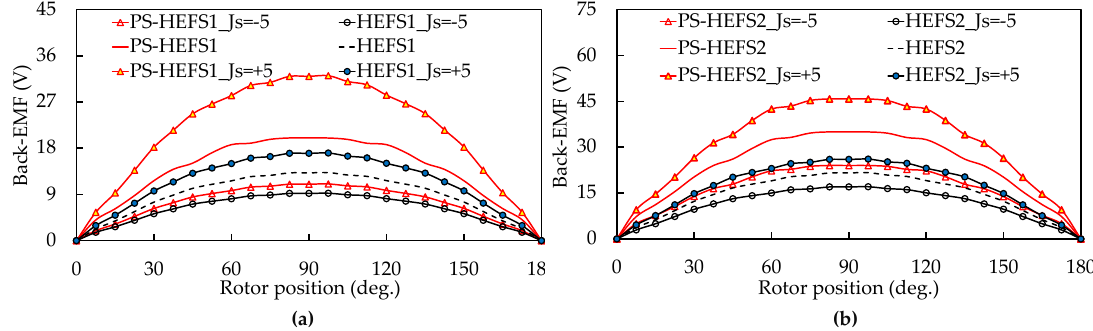
Figure 16. Predicted back-EMF waveforms with different field excitations. ( a ) With iron flux bridges. ( b ) Without iron flux bridges.